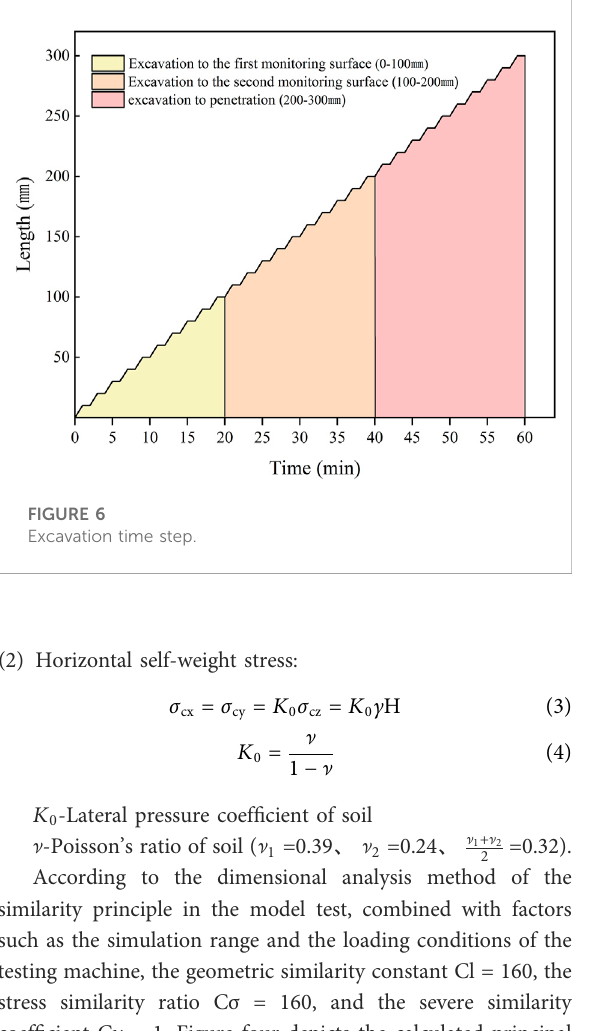
FIGURE 7 Monitoring section after excavation: (A) Experimental results of excavation face 1, (B) Experimental results of excavation face 2, (C) 3Dscanningimageofexcavationface3, (D) 3Dscanningimage of excavation face